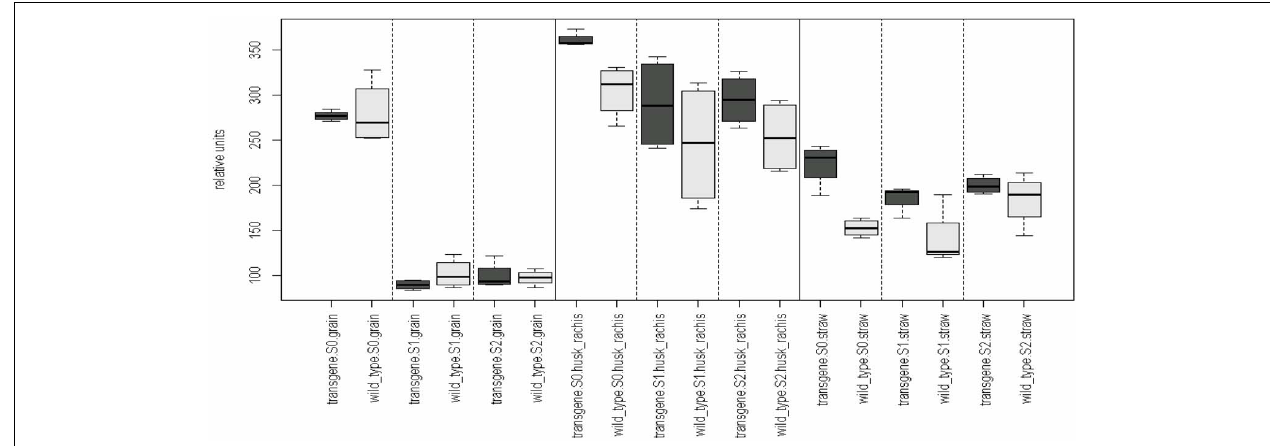
FIGURE 1 | Genotypic effect of the RNAi-approach on the metabolome. Comparison of the means of the influence factor “genotype” (transgene vs. the wild type) for each level of the remaining influence (organs and sulfur fertilization rate). Multiple contrast tests for ratios of means. None of the comparisons revealed significant mean differences between the means. For example, in the first comparison, the mean of group “transgene, S0, grain”